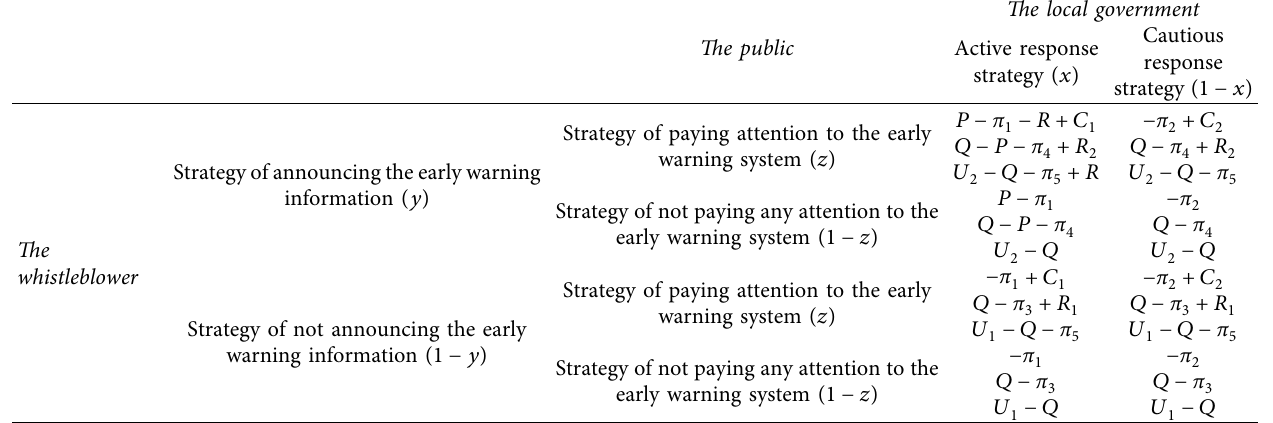
Table 1: The payoff matrix of the local government, the whistleblower, and the